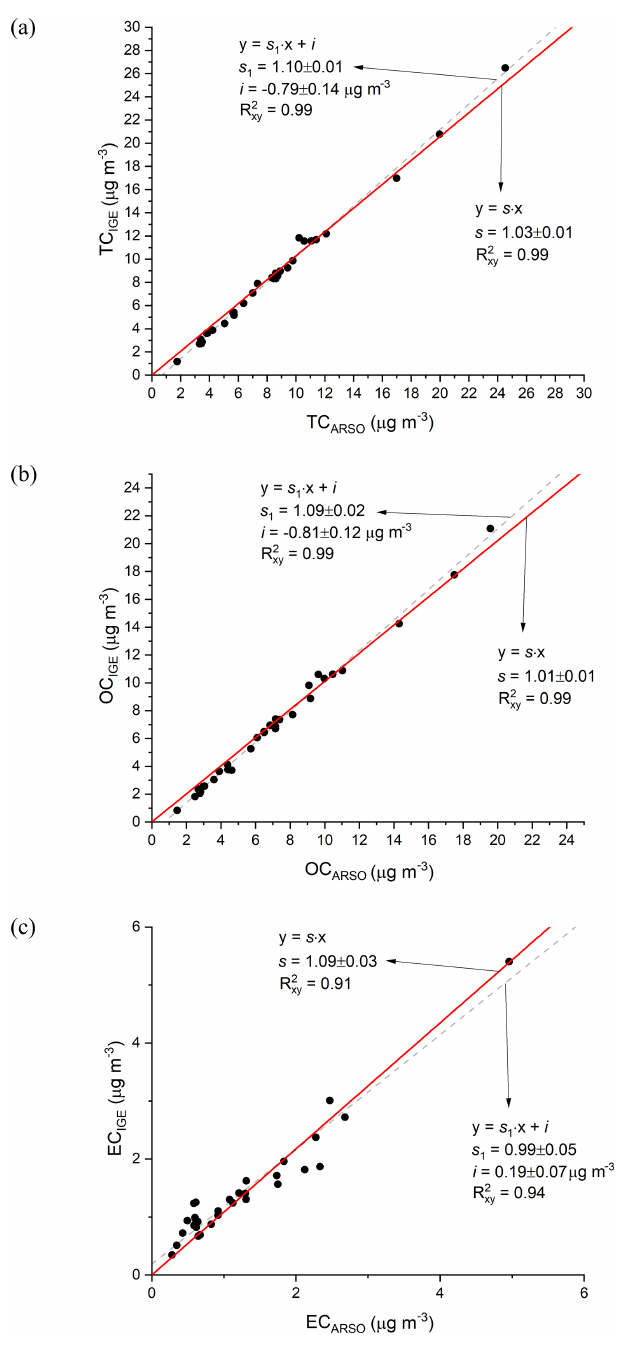
Figure 4. Comparisons of offline measurements of (a) TC, (b) OC and (c) EC from the ARSO and IGE laboratory analyses. OC and EC were measured using the EUSAAR_2 thermal protocol. Linear orthogonal regression results are shown with s as the slope (red line) for the model without an intercept and with s 1 as the slope and i as the intercept (dashed gray line) for the model with an intercept. R 2 xy is the square of the Pearson correlation coefficient. A total of 31 samples were collected for analysis during the campaign.